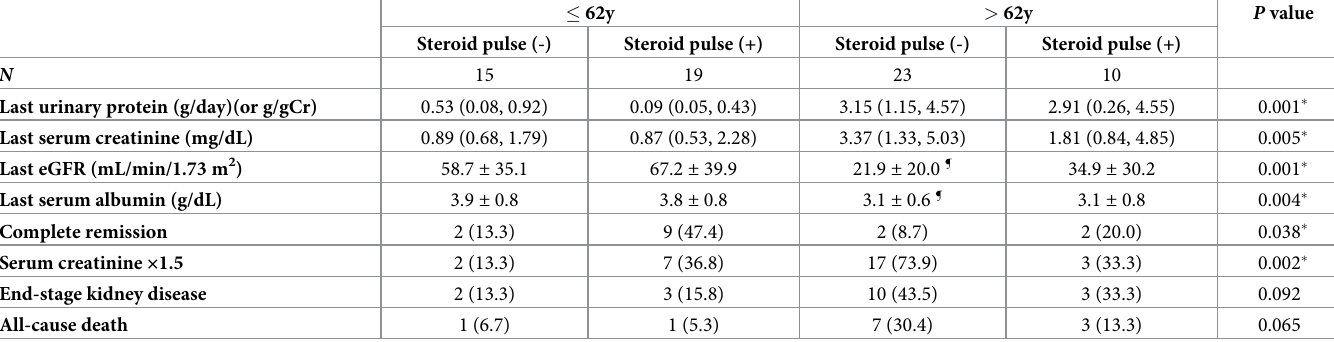
Table 4. Outcomes in patients with IC-MPGN stratified by median age (62 y) and with or without steroid pulse therapy at initial